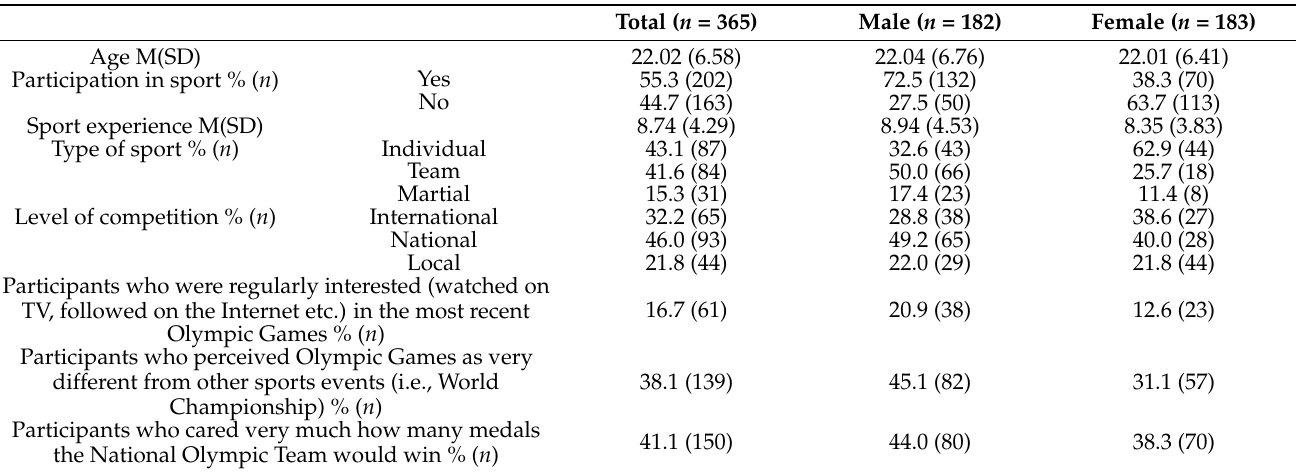
Table 1. Study sample description.